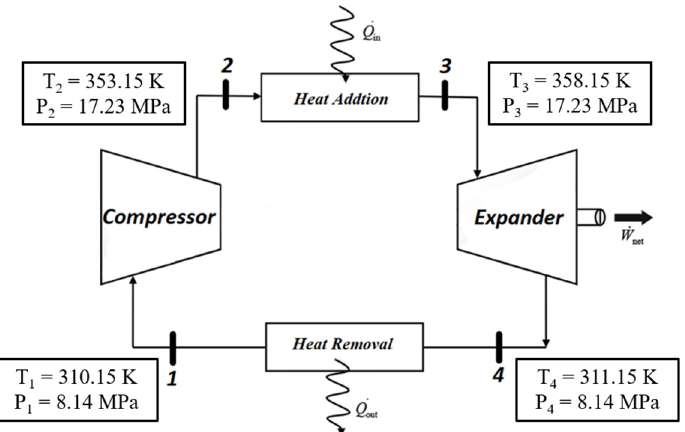
Figure 1. Closed-loop sCO 2 Brayton cycle.